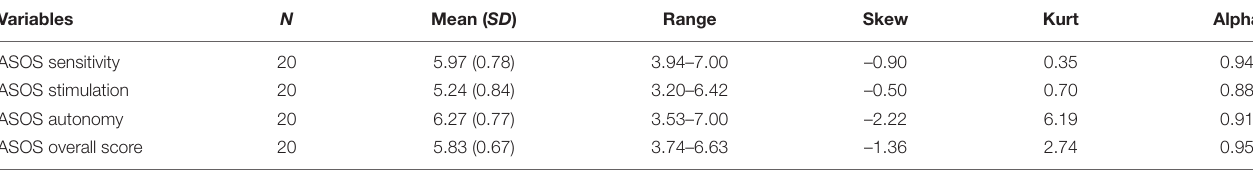
TABLE 4 | Adult style observation schedule subscales and overall score.